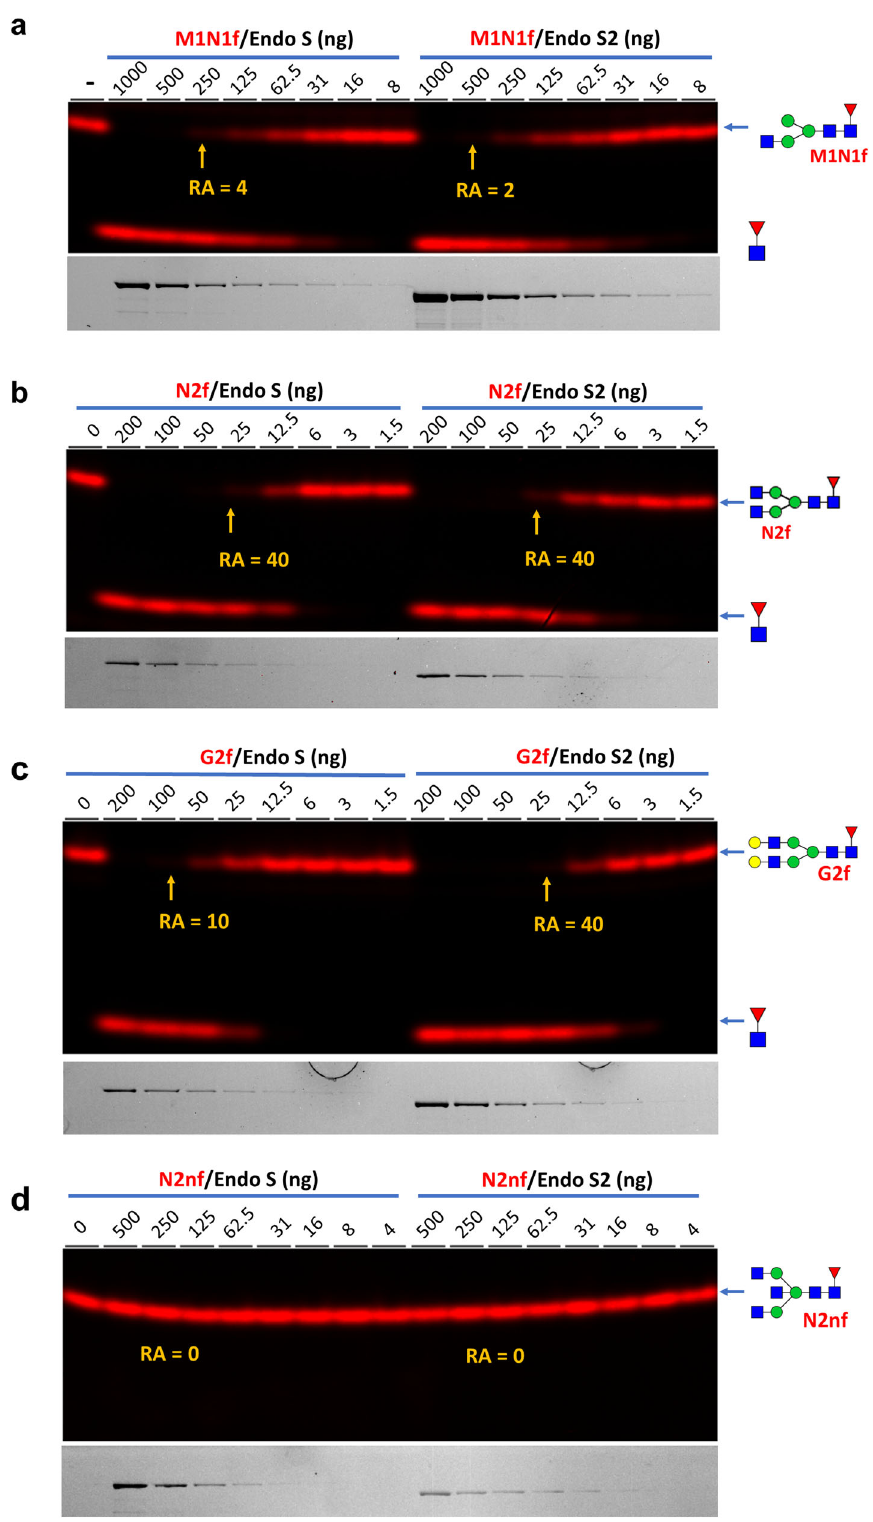
Fig. 5 Relative activity measurements of Endo S/S2 on representative glycans. Different glycans were digested with indicated amounts of Endo S/S2 and separated on 15% gels and imaged for both glycans and proteins. The RA of each measurement are shown. a Relative activity on M1N1f. b Relative activity on N2f. c Relative activity on G2f. d Relative activity on N2nf. Except d where samples were digested for 18 h, all other samples were digested for 1 h at 37